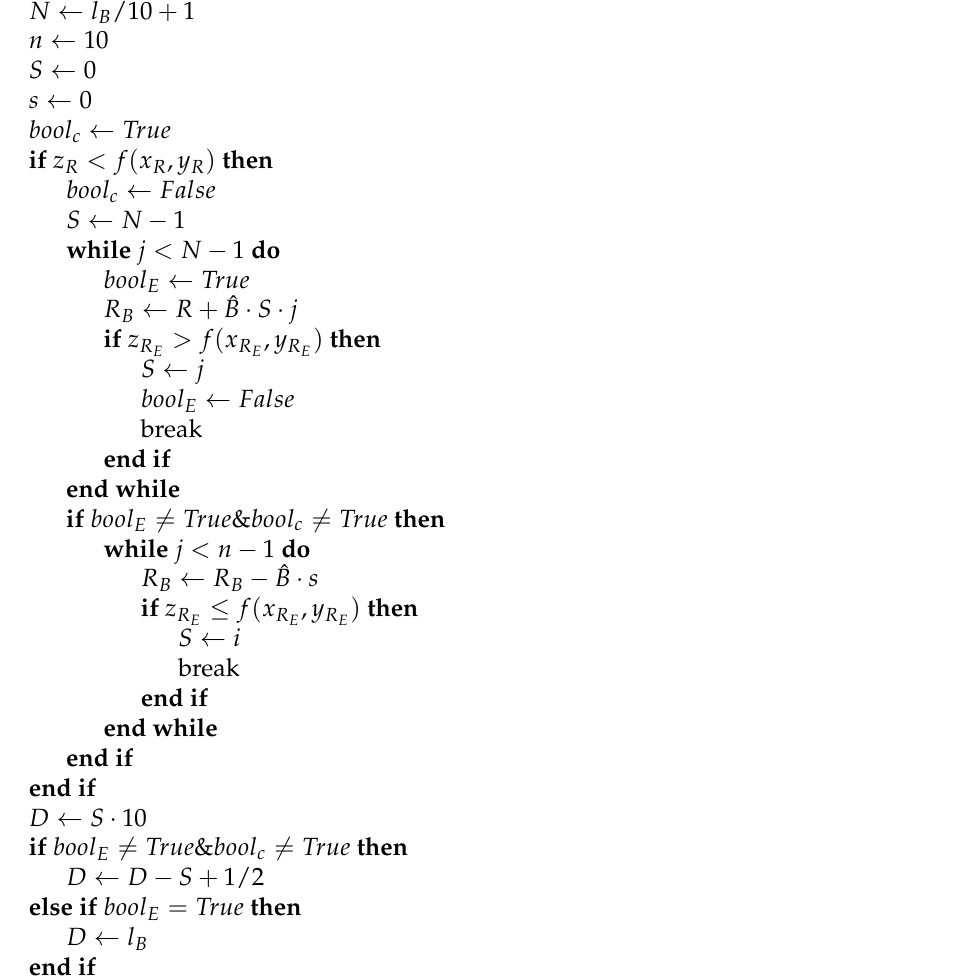
Algorithm 1 Beam reflection—Scenario